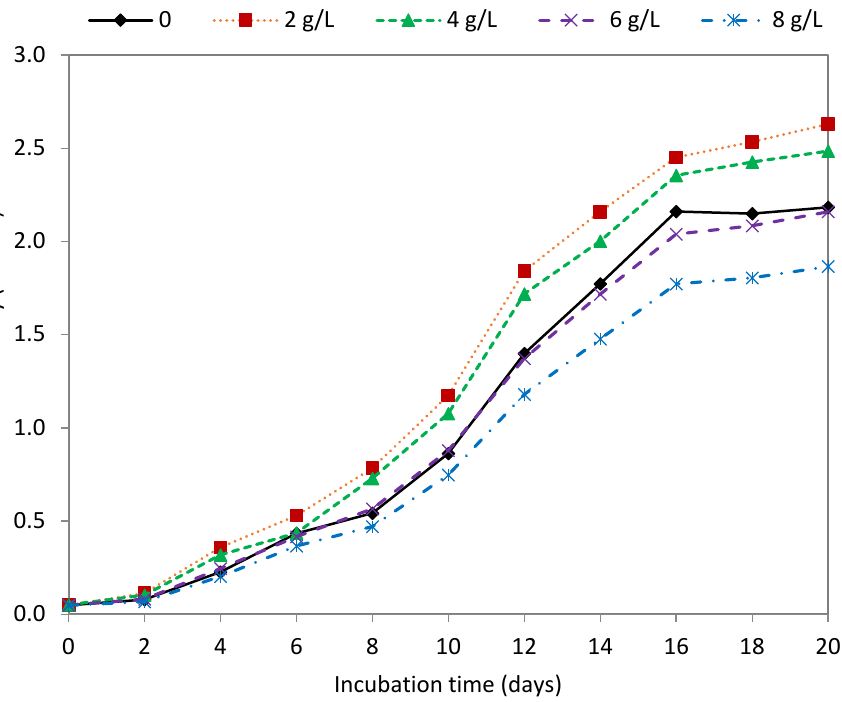
Figure 3. Effect of different concentrations of glycerol on growth of Chlorella sp. cultivated for 20 days in synthetic wastewater.